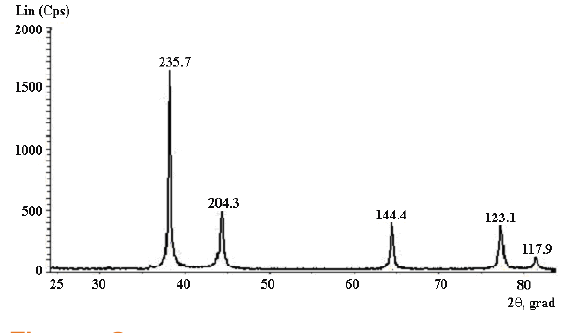
Figure 3. XRD-pattern of elemental silver isolated from initial Ag- GIM .